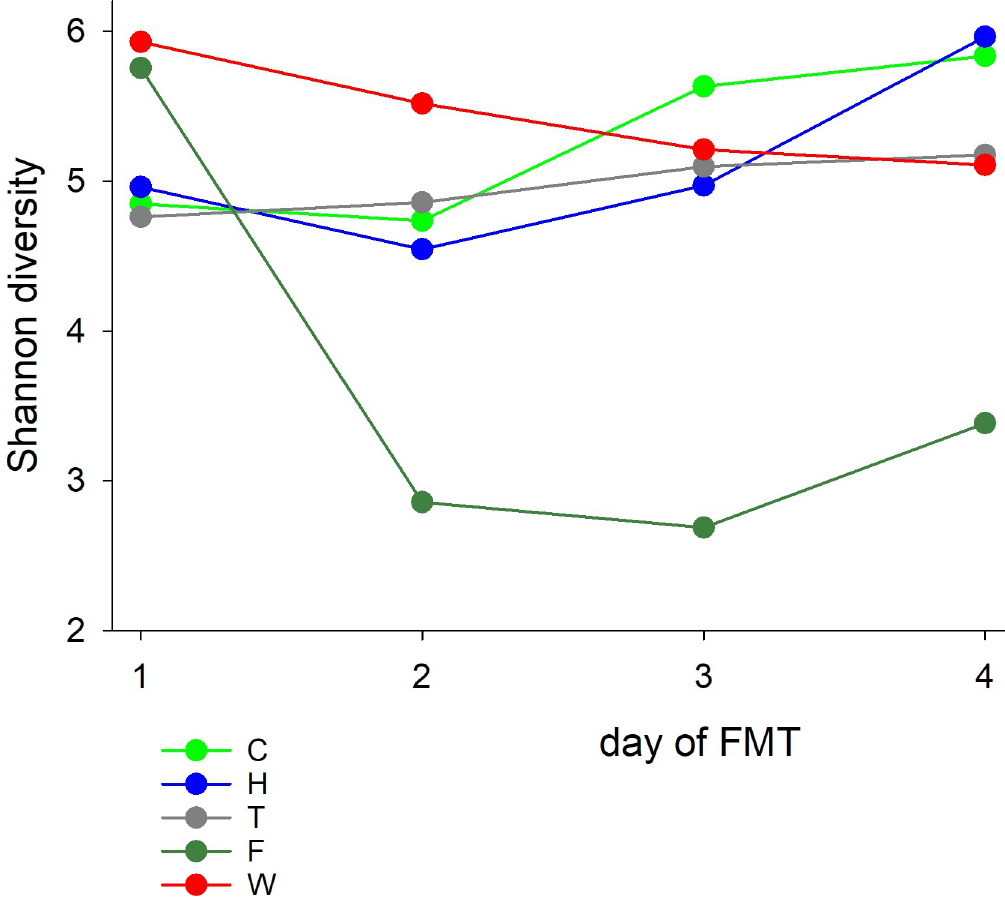
Fig 4. Microbiome α -diversity during FMT treatment. In 3 horses which experienced improving diarrhea scores and survived to discharge (C, H, T), the microbiome became more diverse during the 4-day treatment period. This trend was not observed in horses F and W